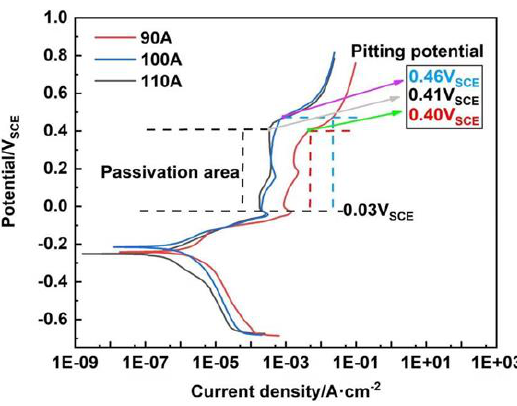
Figure 7. Potentiodynamic polarization curves of samples under different current.